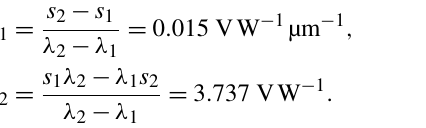
Figure 5. Thermopile detector TS-76.